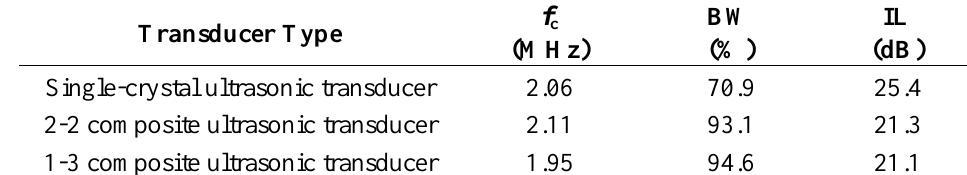
Table 5. Performance comparison of PIN-PMN-PT single crystal, 2-2 composite and 1-3 composite transducers.